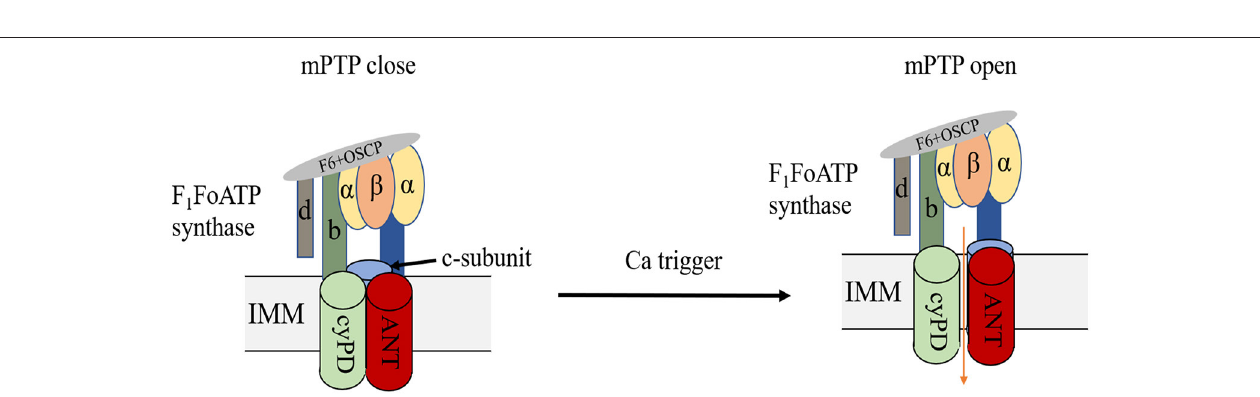
FIGURE 2 | Mechanisms of mitochondria dynamics and mitophagy. Mitochondria are highly dynamic organelles undergoing coordinated cycles of fission and fusion. A series of GTPase-related proteins are involved in the dynamic process. Drp1 is the main regulator of mitochondrial fission, and Mfn1/2, combined with OPA1 regulate the fusion process. After mitochondrial fission, the mitochondrial fragments could be cleared out via PINK/Parkin-mediated mitophagy pathway.